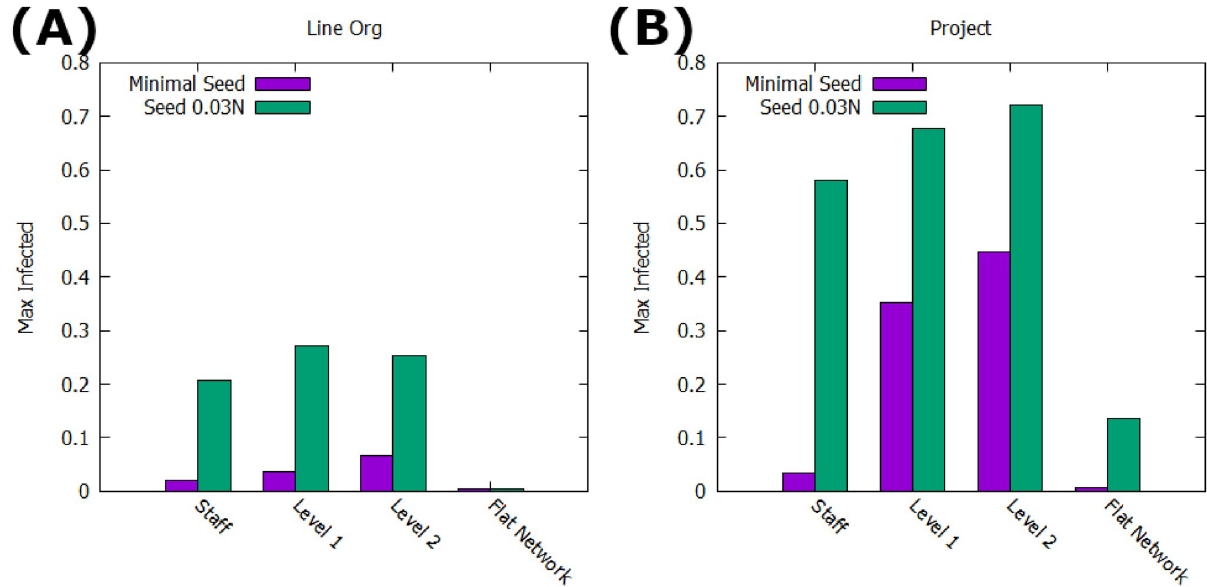
Fig 5. Max adoption with SIR dynamics. Shows the average maximum population of nodes in state I for each combination of network, seed size, and seed level, averaged over 1000 runs. Includes a ‘flat network’ consideration, where management advantages are removed. A: Average max reach in the Line Org network structure. B: Average max reach in the Project network